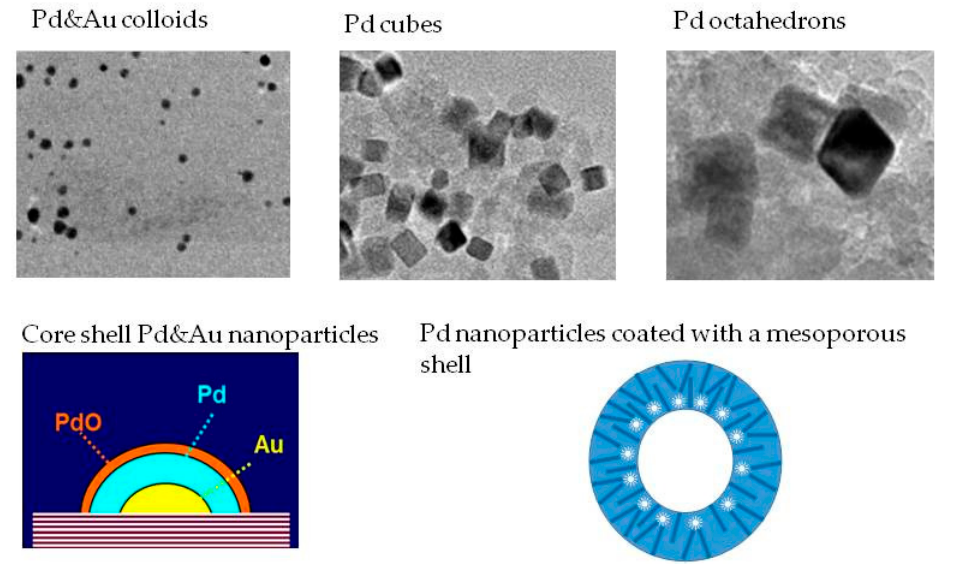
Figure 7. The different morphologies of the catalysts reported in this paragraph.